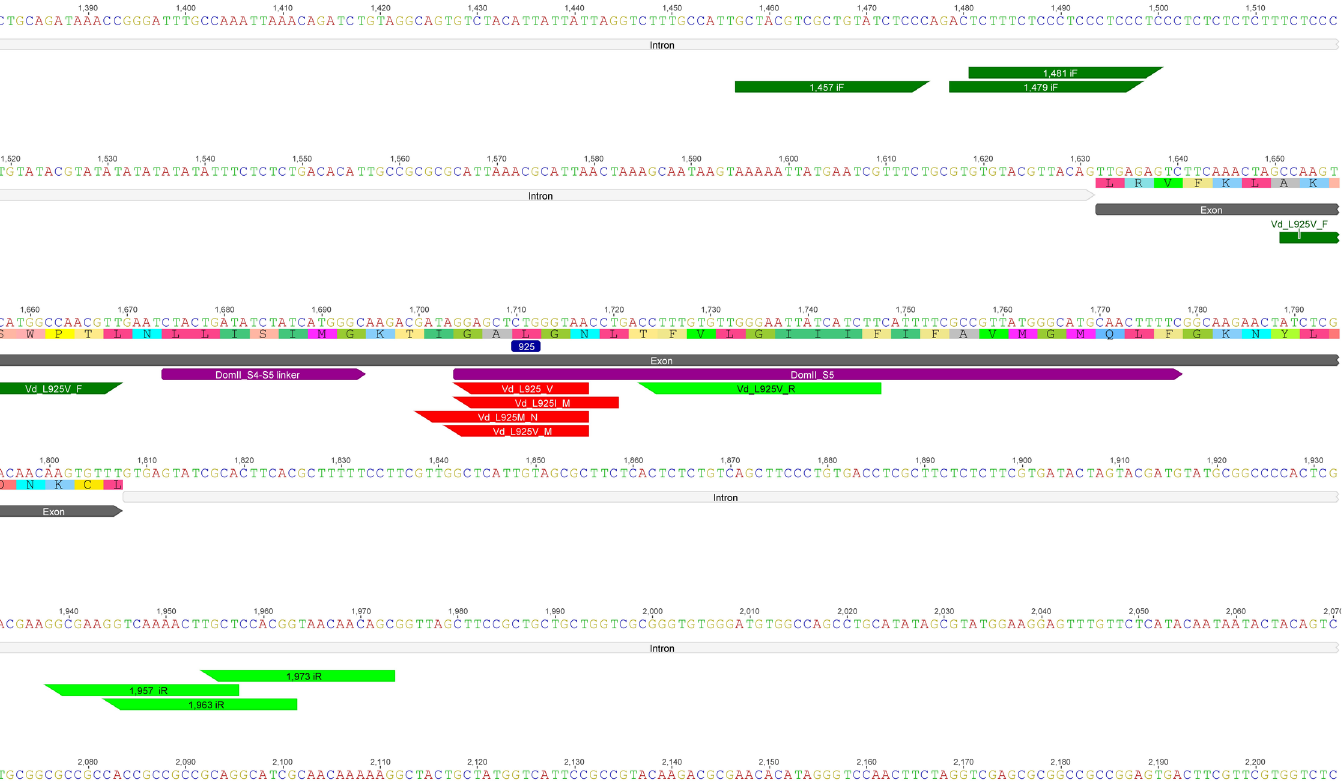
Fig 1. Intron-exon-intron section of the V . destructor VGSC Domain II. Section including the linker between transmembrane segments 4 and 5 (DomII_S4-S5) and the transmembrane segment 5 (IIS5) [in magenta]. Intron [light grey] and exon regions [dark grey], as well as the annealing positions for primers [green] and TaqMan 1 probes [red] are shown. Numbering corresponds to that in Accession KC152655. The position of the residue 925 of the channel protein is highlighted in blue.